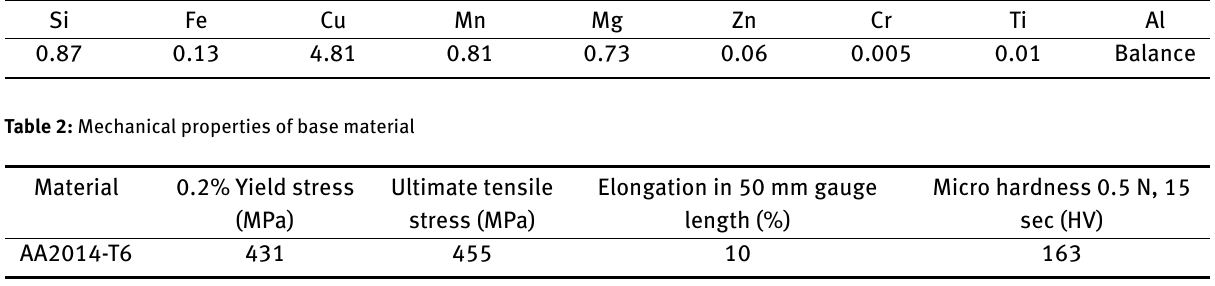
Table 1: Chemical composition (wt. %) of base material Si Fe Cu Mn Mg